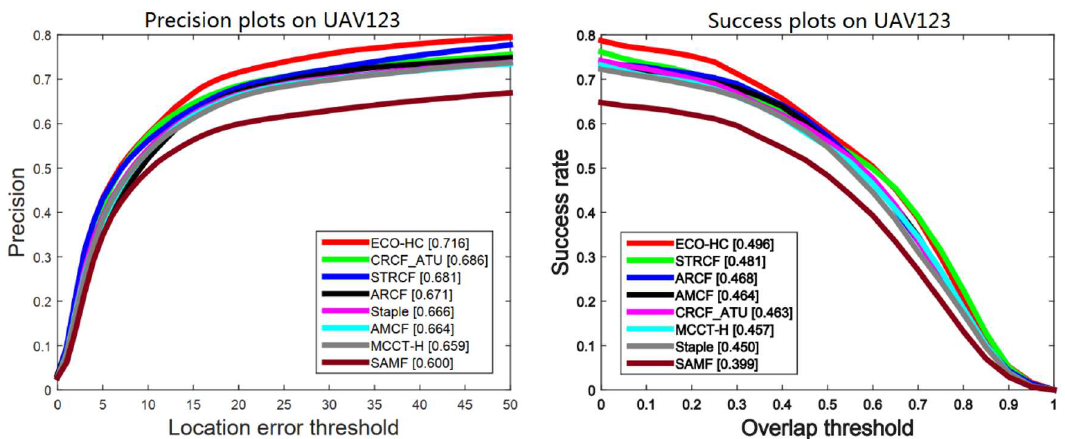
Figure 9. Comparison between CRCF_ATU tracker and existing trackers on UAV123.